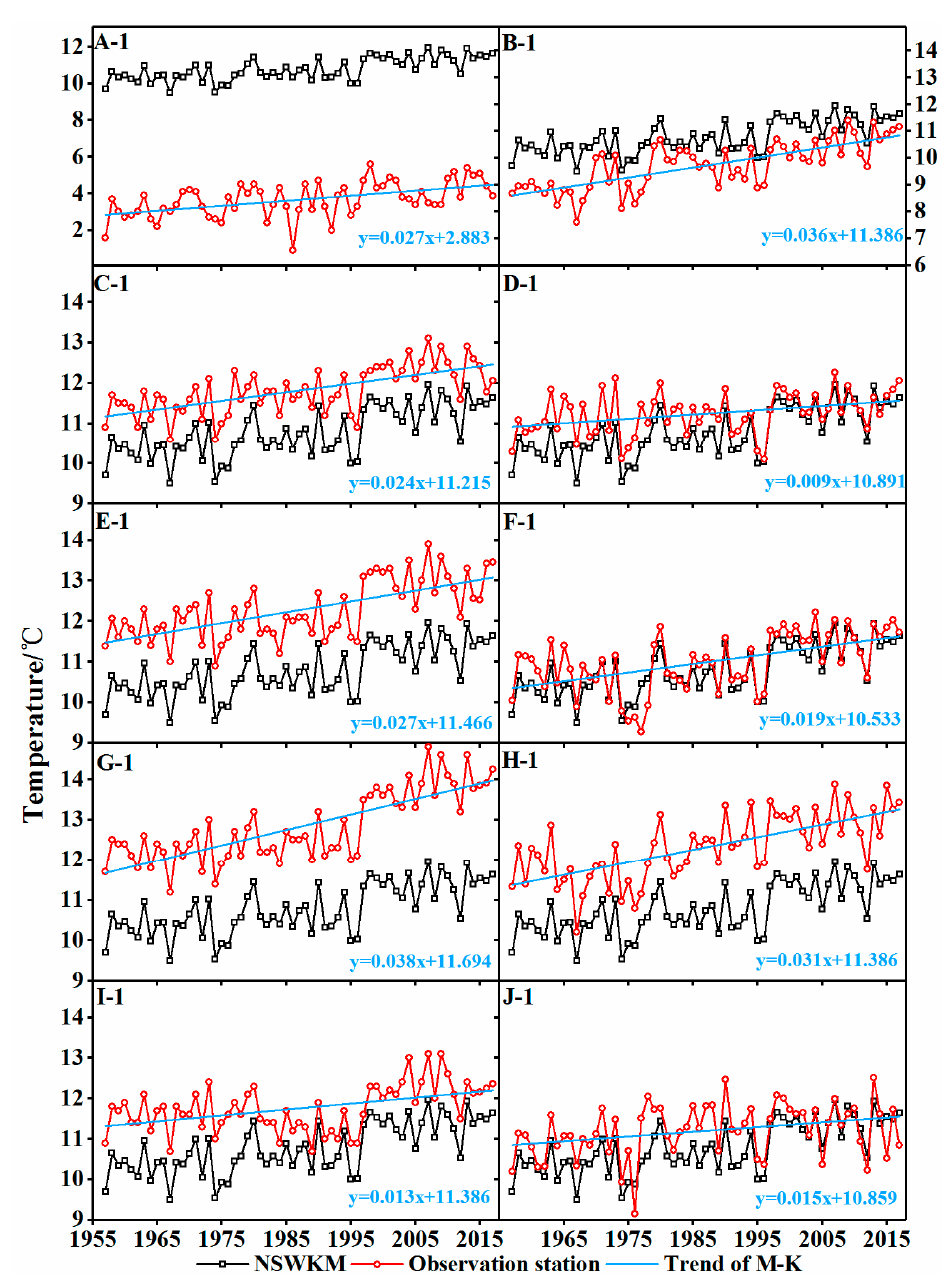
Figure 5. Annual mean temperature of weather stations and hydrological stations on the NSWKM from 1957 to 2017. NSWKM data are average data of all meteorological and hydrological stations (A1–J1). To study SCA change regulation in the four basins at di ff erent altitudes, we divided their altitudes according to elevation di ff erence, using 500 m as a reference, and drew the annual average snow-cover-fraction (SCF) change curves for di ff erent altitudes (Figure 8). Results showed that the YRK, KRK, YUK, and KRY had average SCAs of 17,977.8 km 2 (SCF = 38.60%), 6652.8 km 2 (SCF = 33.39%), 6514.0 km 2 (SCF = 43.95%), and 2799.3 km 2 (SCF = 33.29%), respectively. During seasonal change, the four basins had maximum SCF values in spring. For the whole basin (Figure 8, black curve), annual change curves were M-shaped, i.e., the largest SCF was in spring and autumn, and the smallest SCF was in summer and midwinter (December–January). The maximum SCF of the di ff erent basins occurred in di ff erent periods of time and in di ff erent forms. From these, the YRK had a maximum